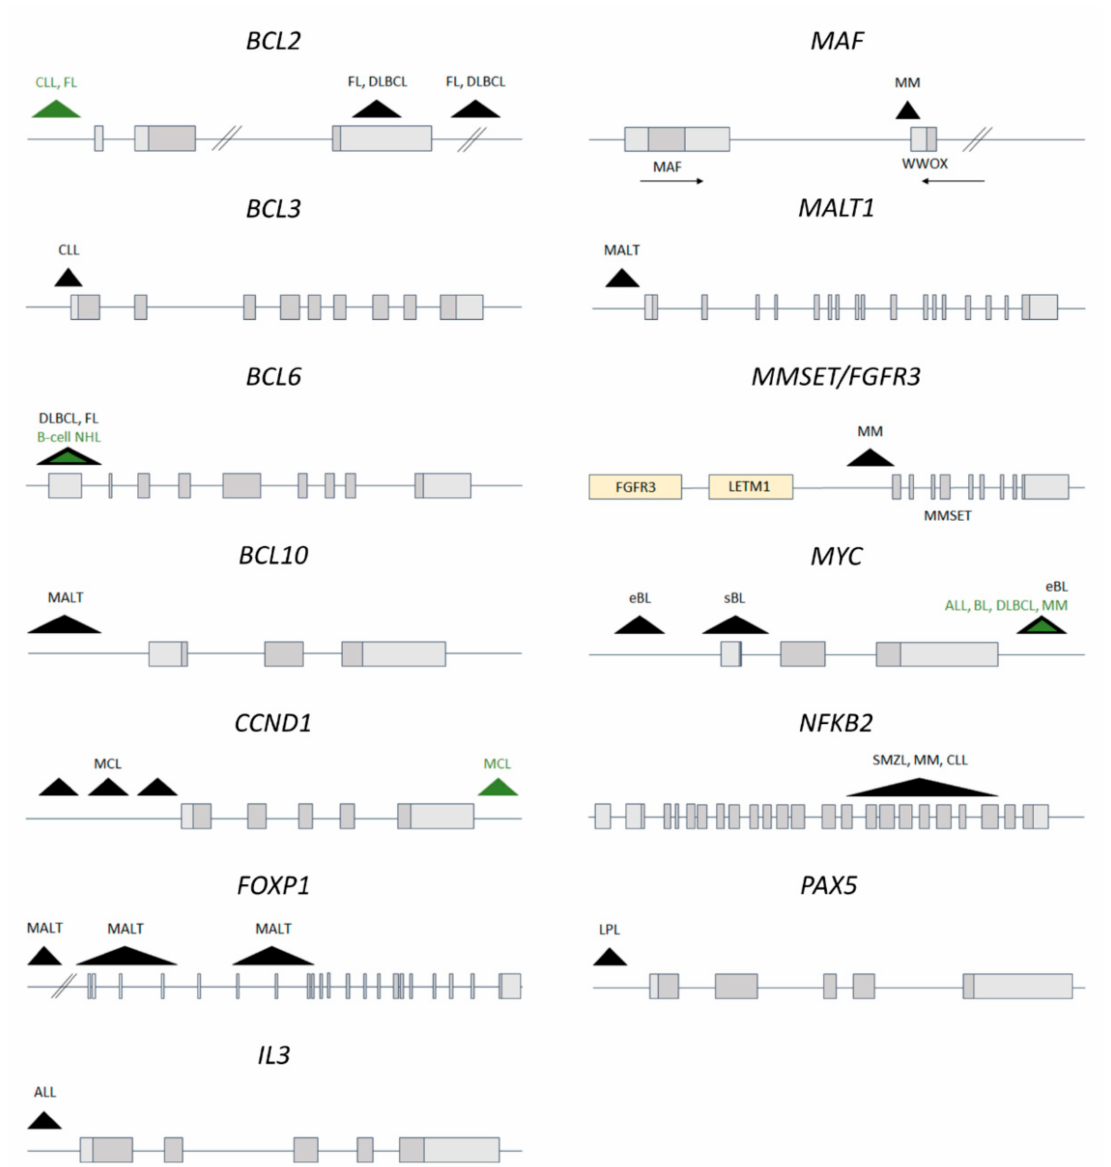
Figure 2. Localization of breakpoints in genes involved in translocations with Ig loci. Black triangles mark regions of breakpoints involved in translocations with IGH locus, green triangles— IGK and IGL loci. Lines depict introns, light grey boxes—noncoding exons, dark grey boxes—coding exons, yellow boxes—whole genes. Genes are oriented 5 (cid:48) → 3 (cid:48) unless indicated otherwise with arrows. ALL, acute lymphoblastic leukemia; eBL, endemic Burkitt lymphoma; sBL, sporadic Burkitt lymphoma; CLL, chronic lymphocytic leukemia; DLBCL, diffuse large B-cell lymphoma; FL, follicular lymphoma; MALT, mucosa-associated lymphoid tissue; MCL, mantle cell lymphoma; MM, multiple myeloma; NHL, non-Hodgkin lymphoma; SMZL, splenic marginal zone B-cell